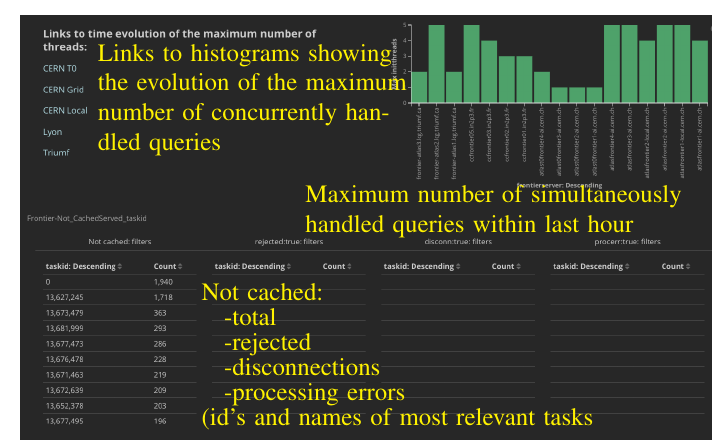
Figure 2. Kibana Dashboard: histogram of concurrent queries (top right) and statistics of not-cached queries (bottom)